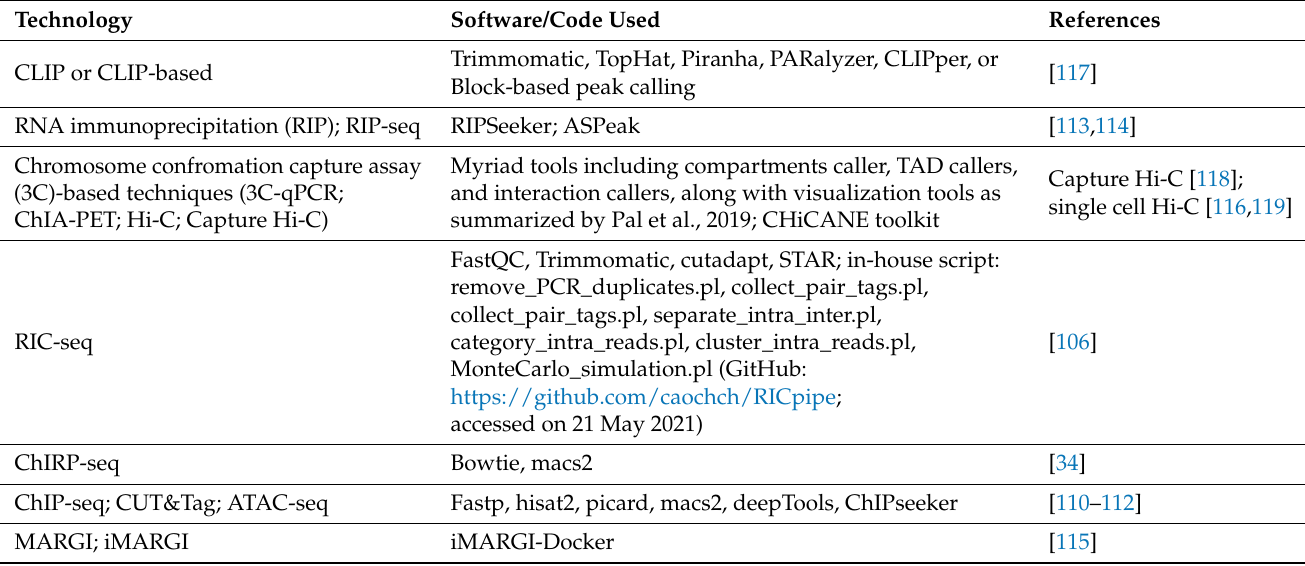
Table 2. Bioinformatic analysis for high-throughput methodologies in lncRNA